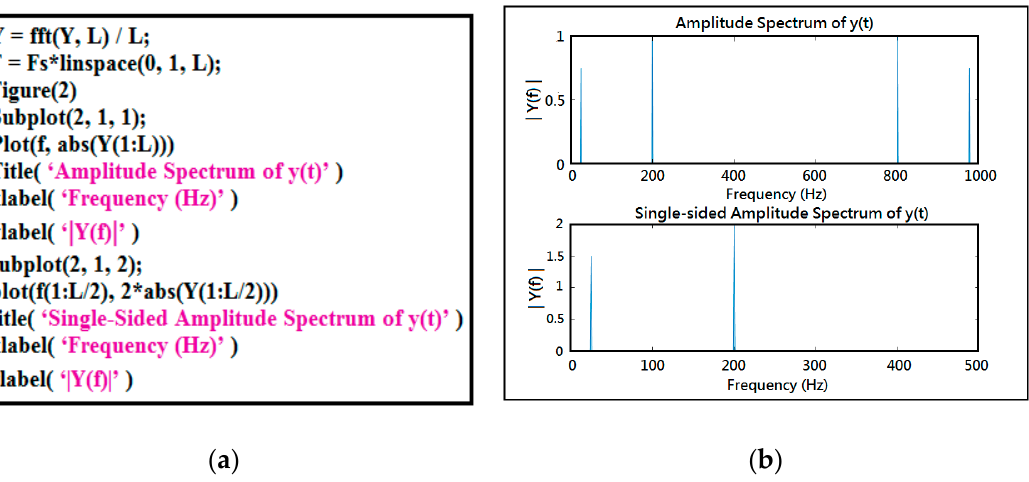
Figure 8. FFT testing figures: ( a ) spectrum program; ( b ) spectrum graphs.